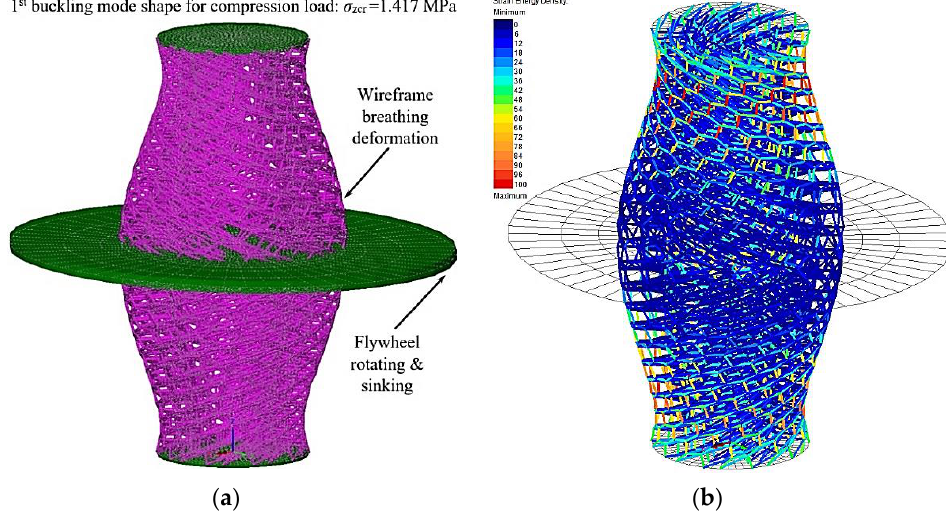
Figure 6. Critical buckling: ( a ) deformed meshed geometry of the joint and ( b ) contours of the strain energy density of the triple-wall wireframe (in the range of 0 – 100 arbitrary units).